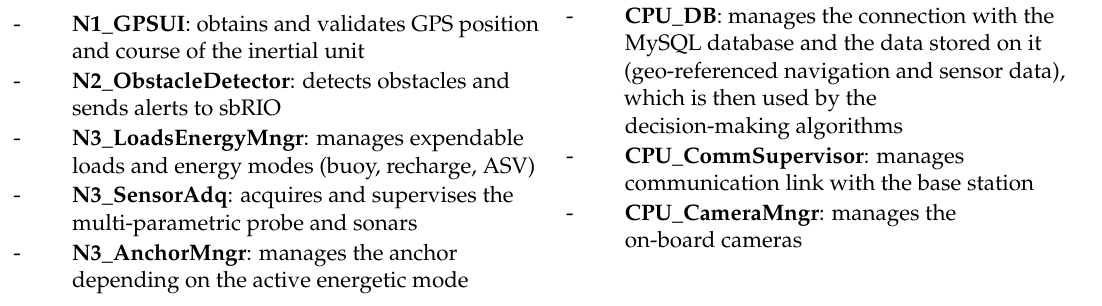
Table 2. Description of software modules.